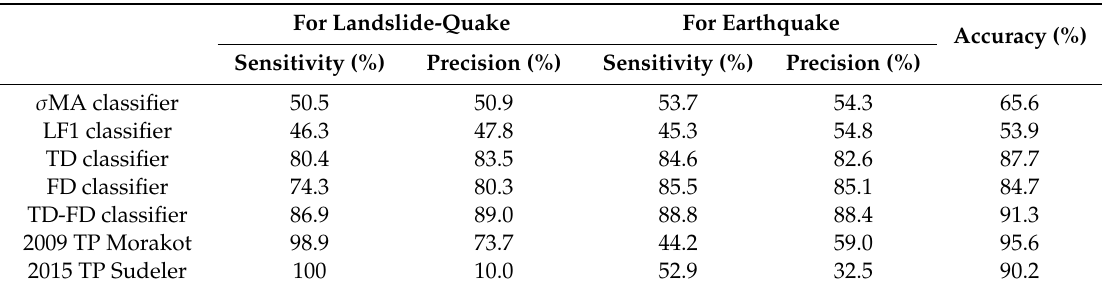
Table 4. Performance of the classifiers created with di ff erent sets of features and validation to two